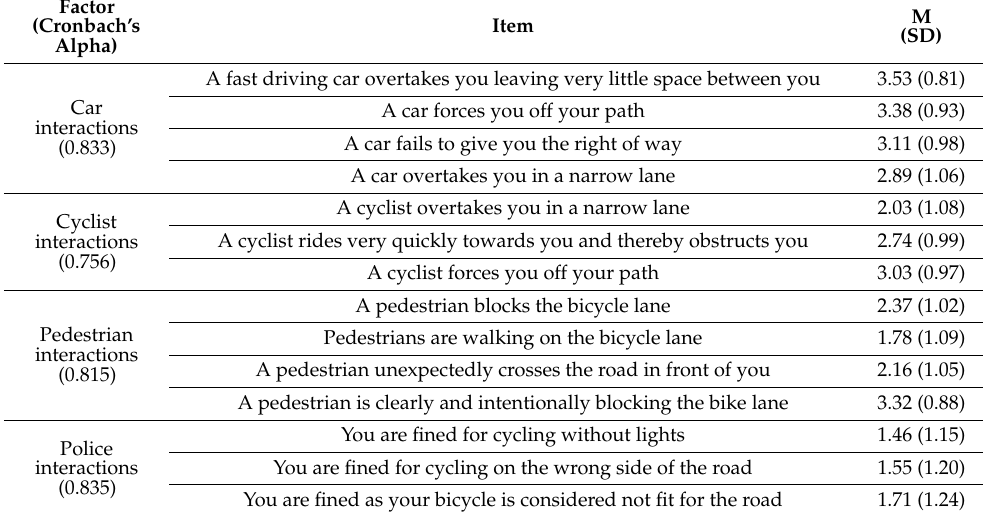
Table 3. Cyclist Anger Scale (CAS) item scores.